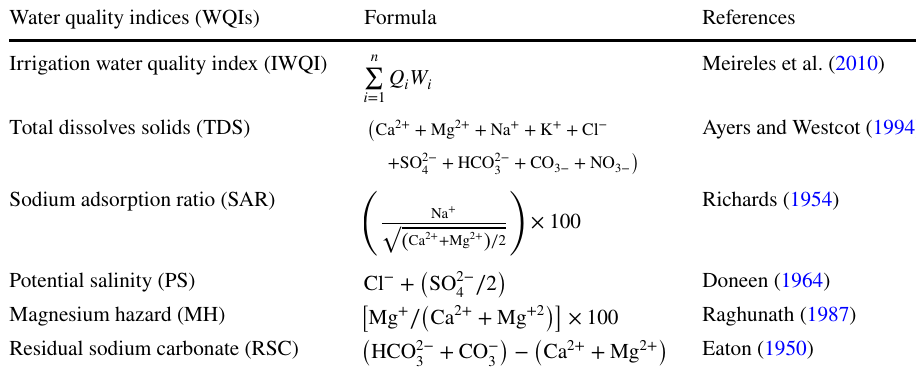
Table 1 The IWQIs, formula,